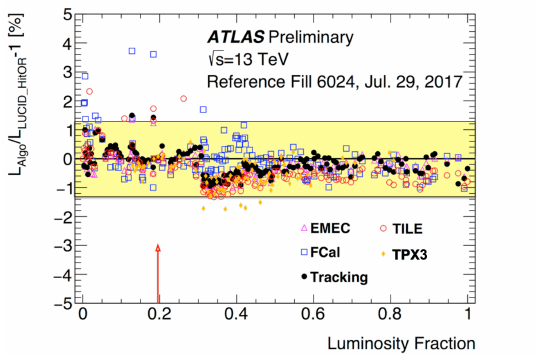
Figure 69. Fractional differences in run-integrated luminosity between the LUCID BiHitOR algorithm and the TPX3, track-counting, EMEC, FCal and TILE measurements, plotted as a function of the cumulative delivered luminosity normalised to the 2017 total. The luminosity measurements from the other detectors are normalized to that of LUCID in the reference run indicated by the arrow. The assigned ± 1.3% long-term stability uncertainty is shown by the yellow band [37]. Taken from